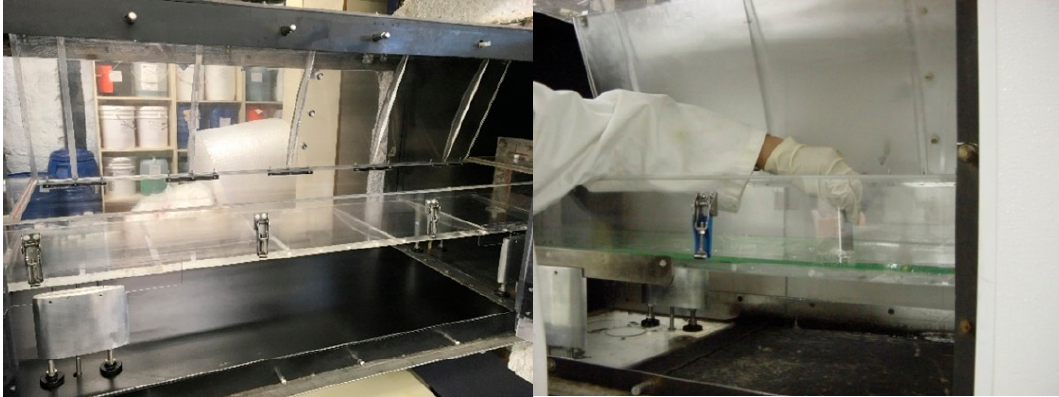
Figure 3. Aerodynamic Acceptance Test (AAT) setup.